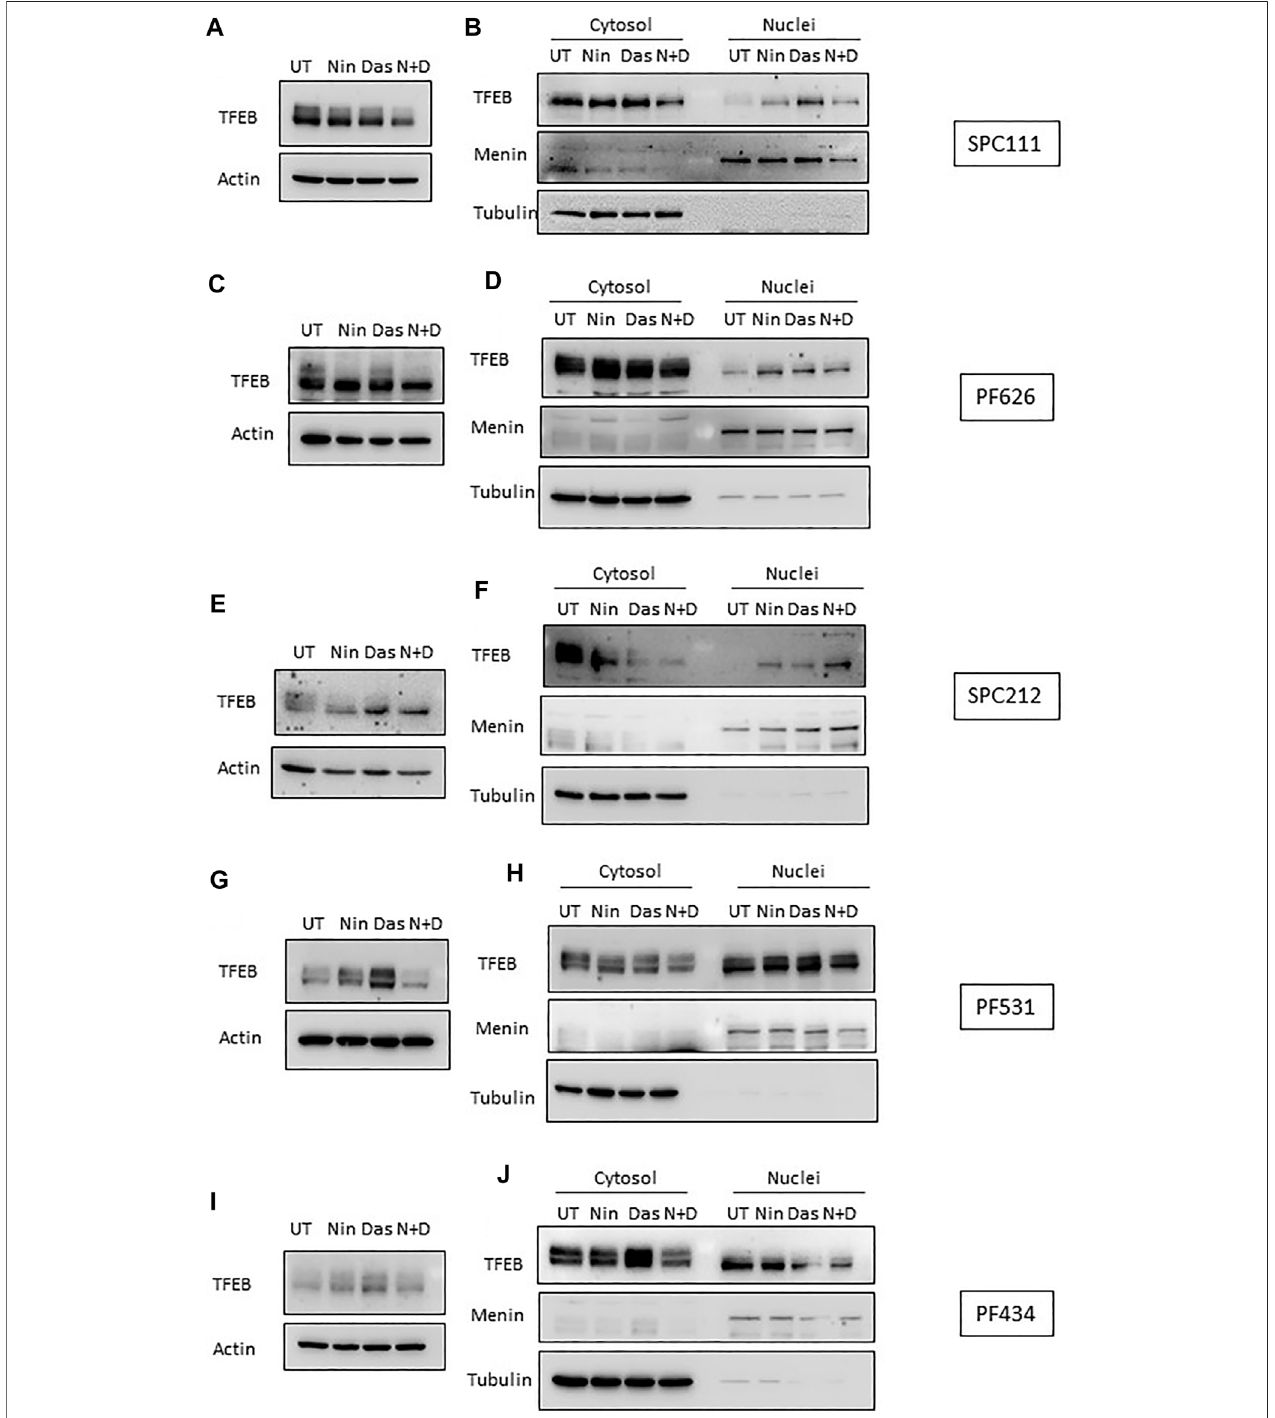
FIGURE 6 | TFEB is de-phosphorylated and translocates to the nucleus upon dasatinib and nintedanib treatments. TFEB mobility shifting was analyzed by western-blot (A,C,E,G,I) , and its localization was determined by nuclear fractionation (B,D,F,H,J) upon treatment with the indicated treatments (UT, untreated DMSO control; Das: dasatinib 50 nM; Nin: nintedanib 1 μ M; 24 h; N + D, combination of nintedanib and dasatinib). Menin and Tubulin were used as markers for purity of the nuclear and cytosolic fractions, respectively.